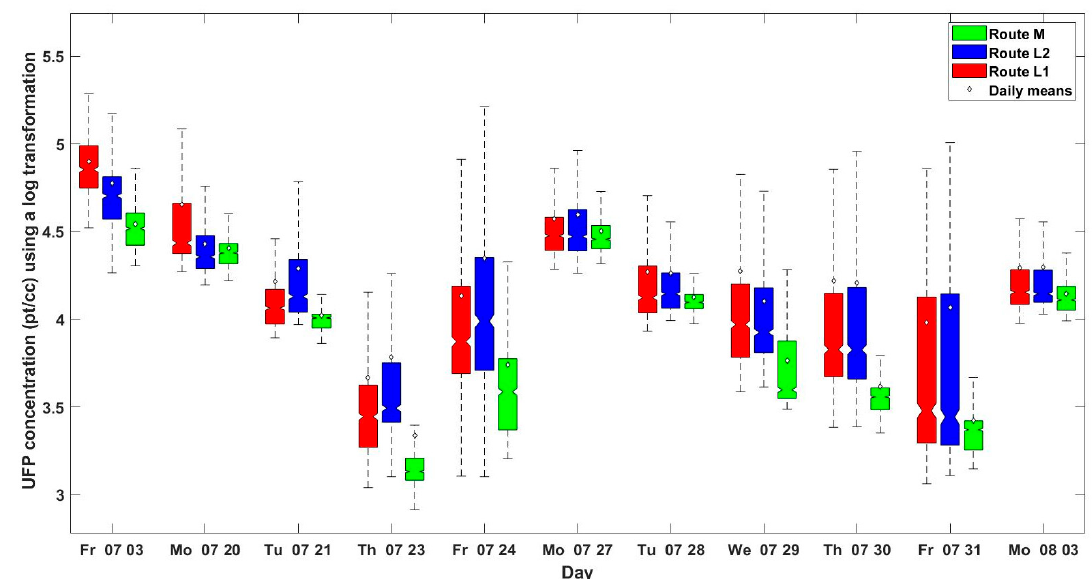
Figure 4. Boxplot of the collected data by day and route. Horizontal lines represent the median, boxes represent the 25th–75th percentiles and whiskers represent the 5th–95th percentiles.